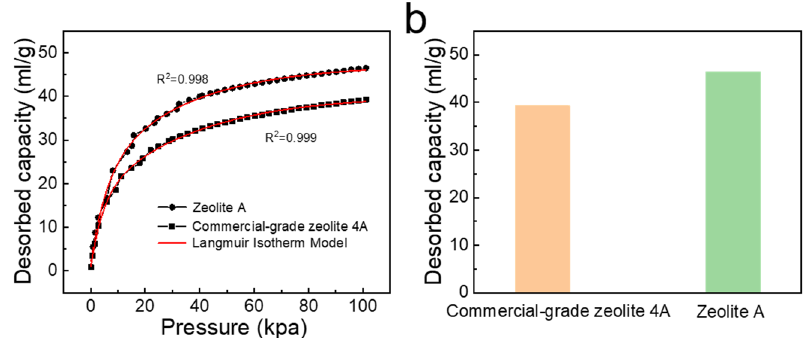
Figure 8. ( a ) Carbon dioxide adsorption isotherm of commercial-grade zeolite 4A and zeolite A at 298 K: Langmuir model fitting; ( b ) the histogram of maximum adsorption amount for carbon dioxide: commercial-grade zeolite 4A and zeolite A.